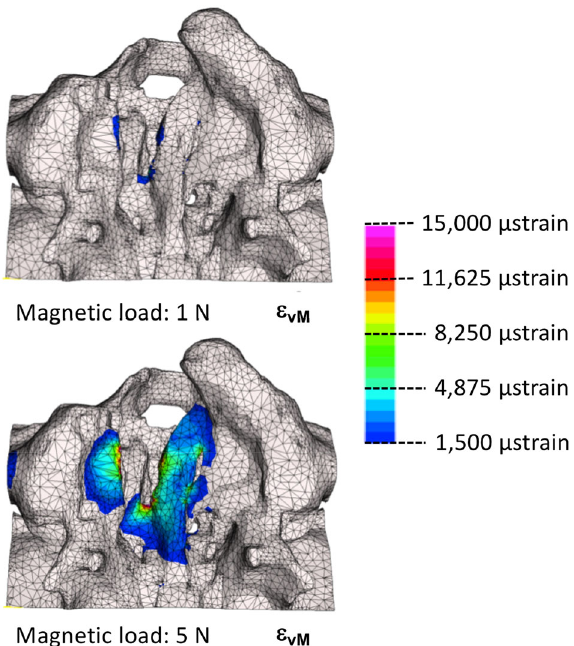
Fig. 7 The distribution of the von Mises strains for magnetic load of 1 N and 5 N in the range of 1,500 to 15,000 μ strain (palatal view with the X-axis pointing coronally, Y-axis pointing left and Z-axis pointing posteriorly). Note that the non-colored regions are not subject to adaptive